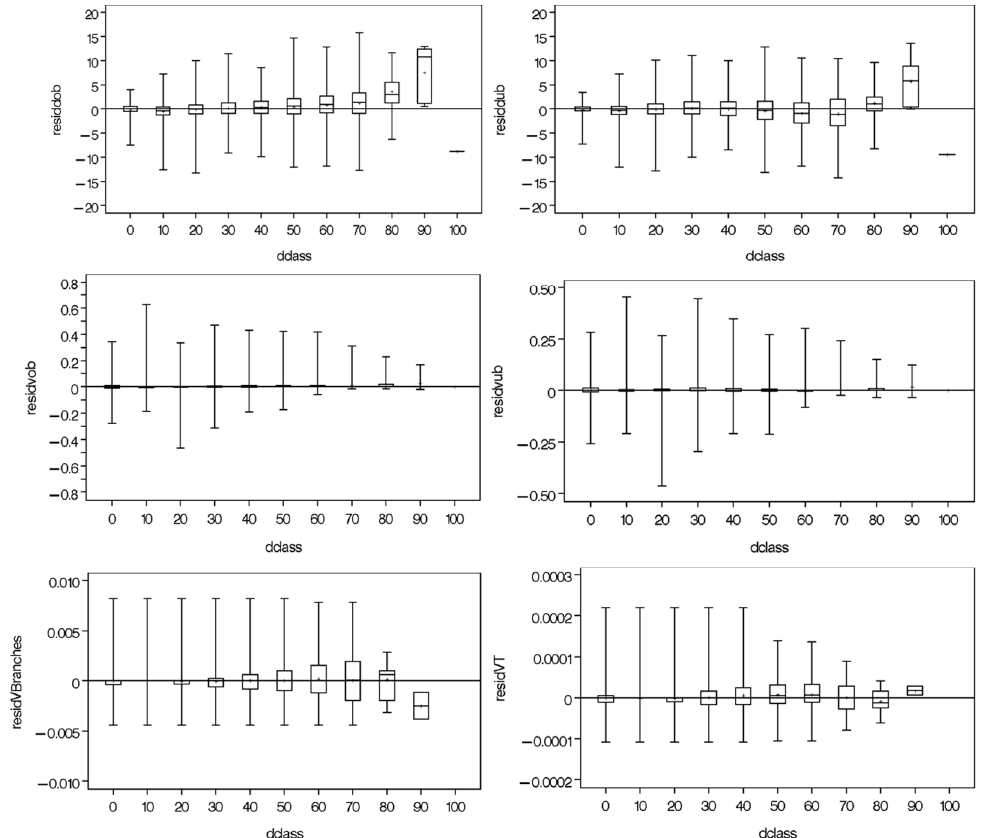
Figure 3. Box-and-whisker plots of the unweighted residuals for the variables of study against diameter class (cm) for Pinus durangensis. The boxes represent the interquartile ranges. The upper and lower ends of the whiskers represent the maximum and minimum height prediction errors respectively. where: d ob : diameter over bark (cm); d ub : diameter under bark (cm); v ob : merchantable volume over bark (m 3 ); v ub : merchantable volume under bark (m 3 ); V branches : coarse branches (>5 cm)